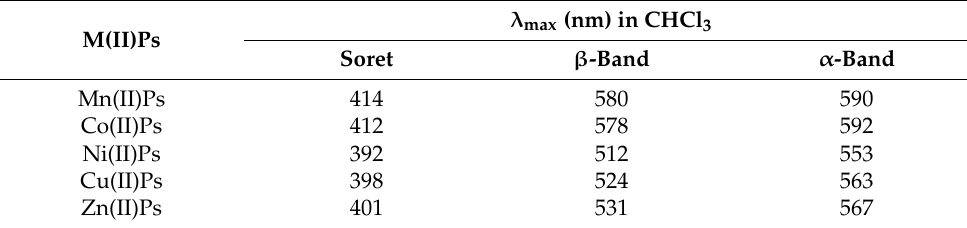
Table 3. UV-Vis data of petroleum metalloporphyrins synthesized in the present work.